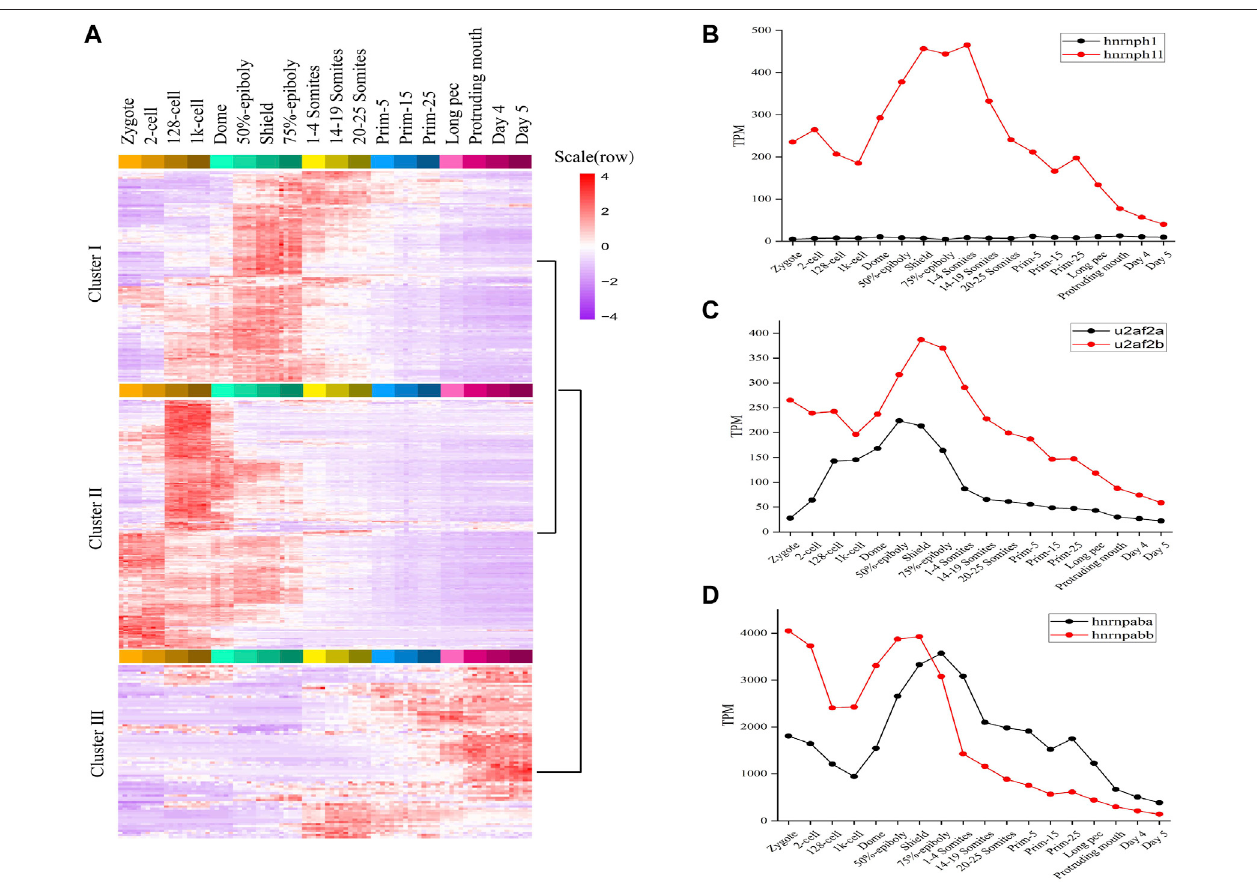
FIGURE 2 | The expression pro fi les of splicing factors in zebra fi sh. (A) The expression map and unsupervised clustering of splicing factors during embryogenesis development. (B – D) The expression level of three categories splicing factors having two orthologous forms. The expression level of hnrnph1/hnrnph1l, u2af2a/u2af2b and hnrnpaba/hnrnpabb was plotted in (B – D) ,